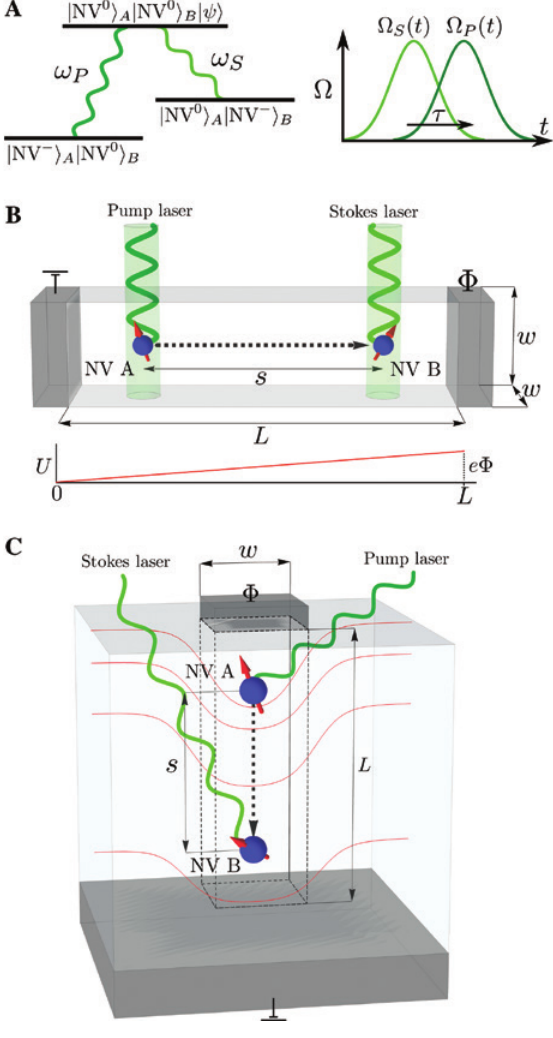
Figure 1: Design schematics for quantum transport of an electron between NV centers using